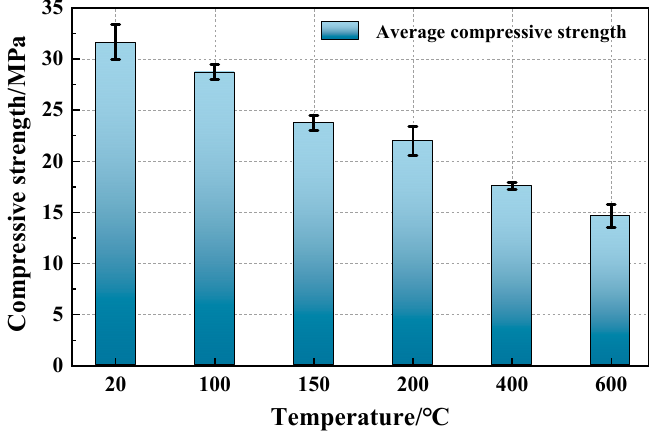
Figure 4. Compressive strength of HSFCM after treatment at di ff erent temperatures.